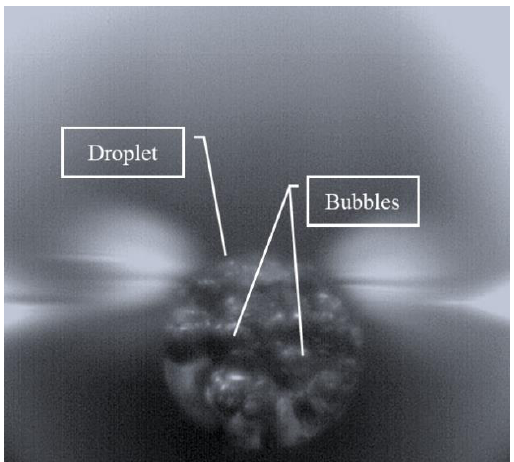
Figure 8. The imaging of a Colorado crude oil droplet with homogeneous bubble nucleation and growth inside the fuel droplet.